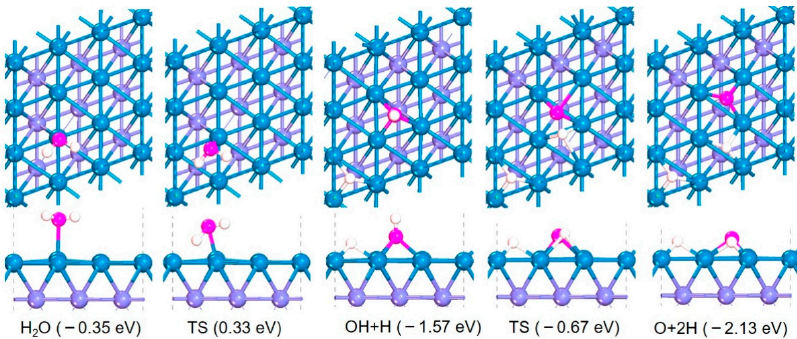
Figure 1. Structures and energies of H 2 O direct dissociation to O* + 2H*.